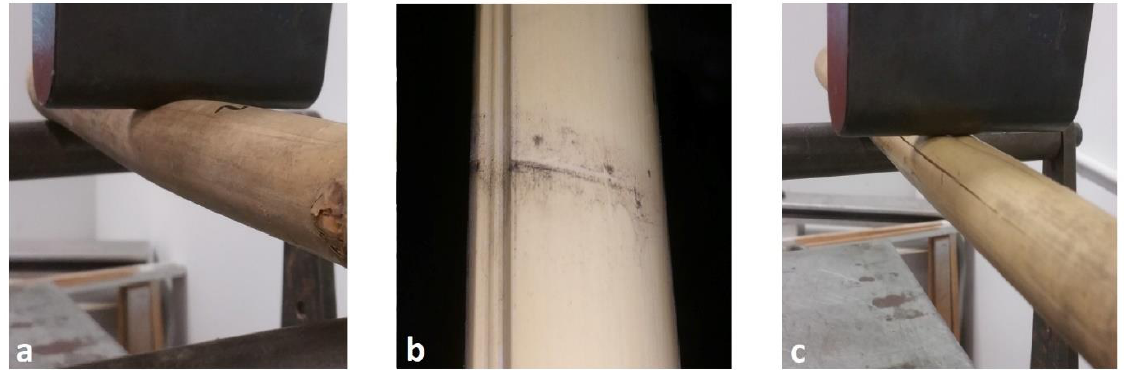
Figure 5. Pictures of fracture after bending test for ( a ) DS, ( b ) PA, and ( c ) AA. The latter (Figure 5c) have a lateral flaring in the area where the clamp is applied, which results in bending in the plane of the cross-section. With reduced strength in the plane transverse to the direction of the fibers, longitudinal cracks appear along the culm